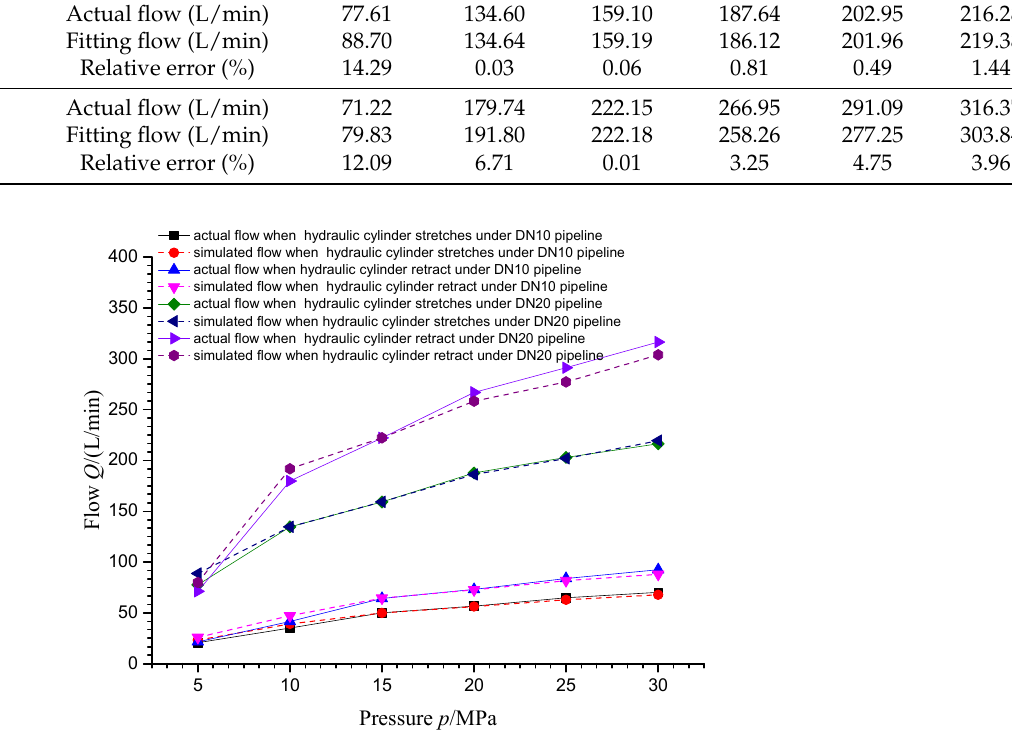
Figure 13. Comparison diagram of actual flow and fitting flow under different pipeline parameters and working conditions.